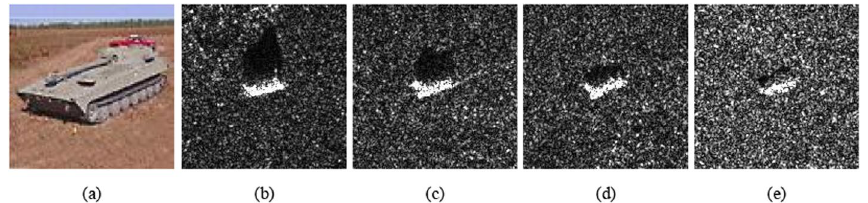
Fig. 1 SAR images of the 2S1 vehicle target at different depression angles. a Optical image. b SAR image with 15° depression angle. c SAR image with 17° depression angle. d SAR image with 30° depression angle. e SAR image with 45° depression